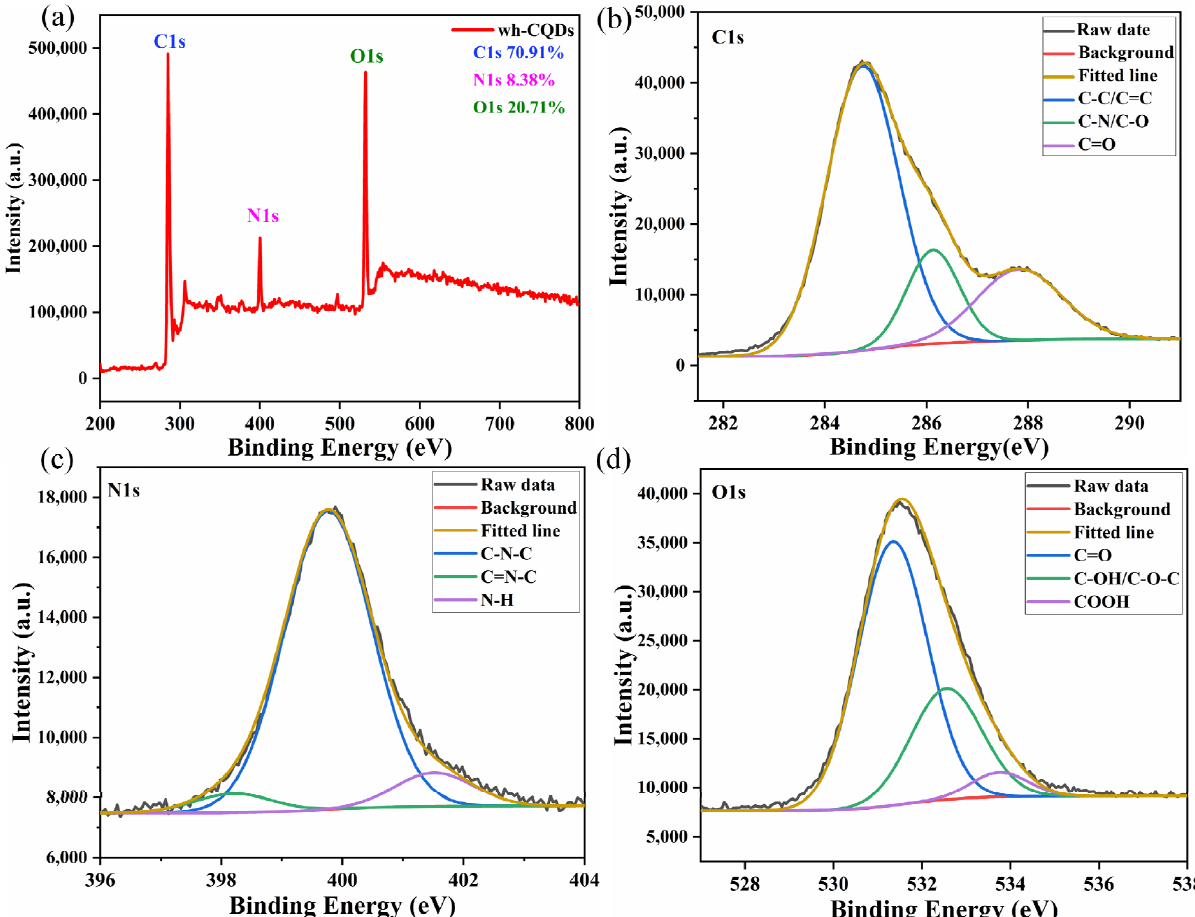
Figure 3. ( a ) XPS full-survey spectrum of wh-CQDs. The high-resolution deconvoluted XPS peaks of wh-CQDs for ( b ) C1s, ( c ) N1s, and ( d ) O1s.